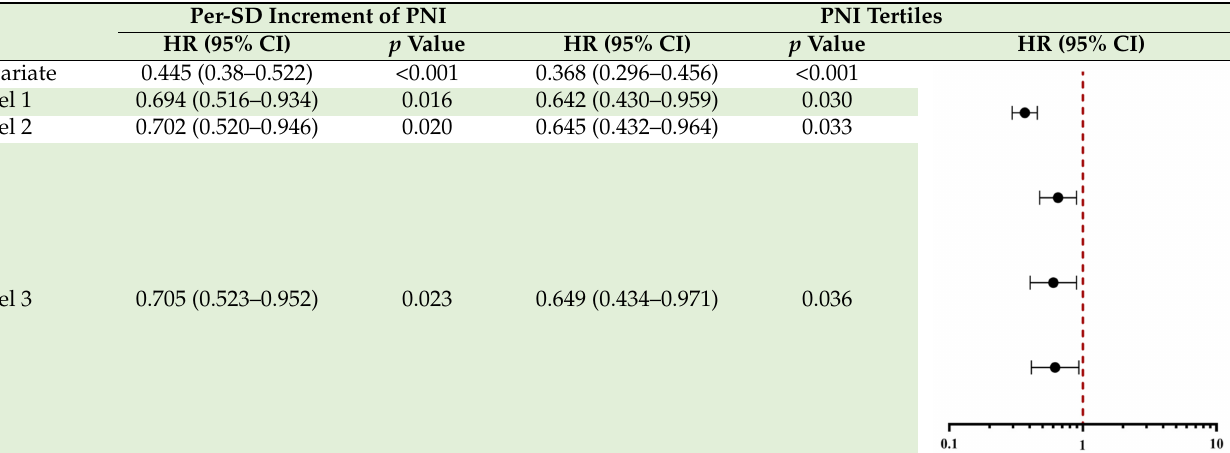
Figure 3. The prediction of PNI for ESRD in DN patients. ( A ) Kaplan–Meier curves of renal survival rate in patients with different PNI levels. ( B, C ) The prediction of PNI at different times for ESRD evaluated with time-dependent receiver operating characteristic (td-ROC) curve. ( D ) The prediction of models for ESRD evaluated with ROC curve. Table 3. Associations between PNI level and renal